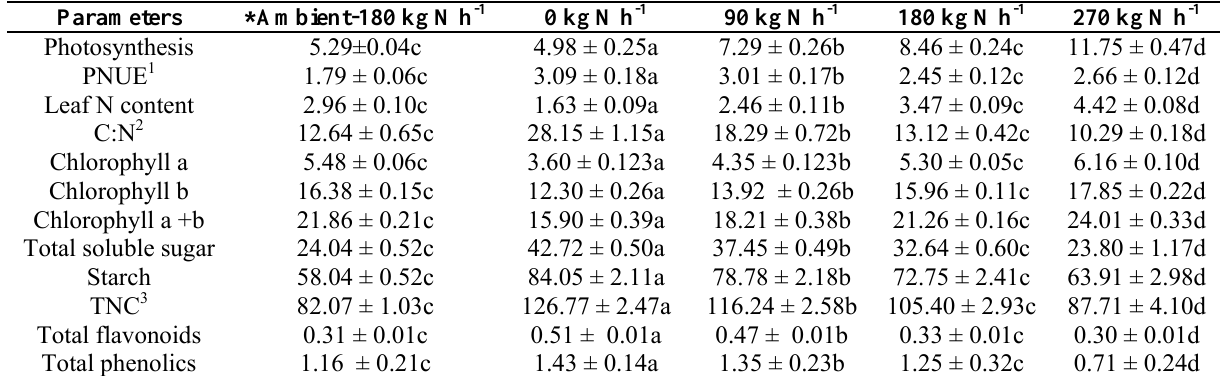
All analyses are mean ± standard error of mean (SEM), N = 15. Means not sharing a single letter were significantly different at P ≤ 0.05. A = Control at ambient CO standard Nitrogen fertilization rates (180 kg N ha -1 ). Table 4. Effects of different nitrogen levels on some physiological parameters in L. pumila Benth. under CO 2